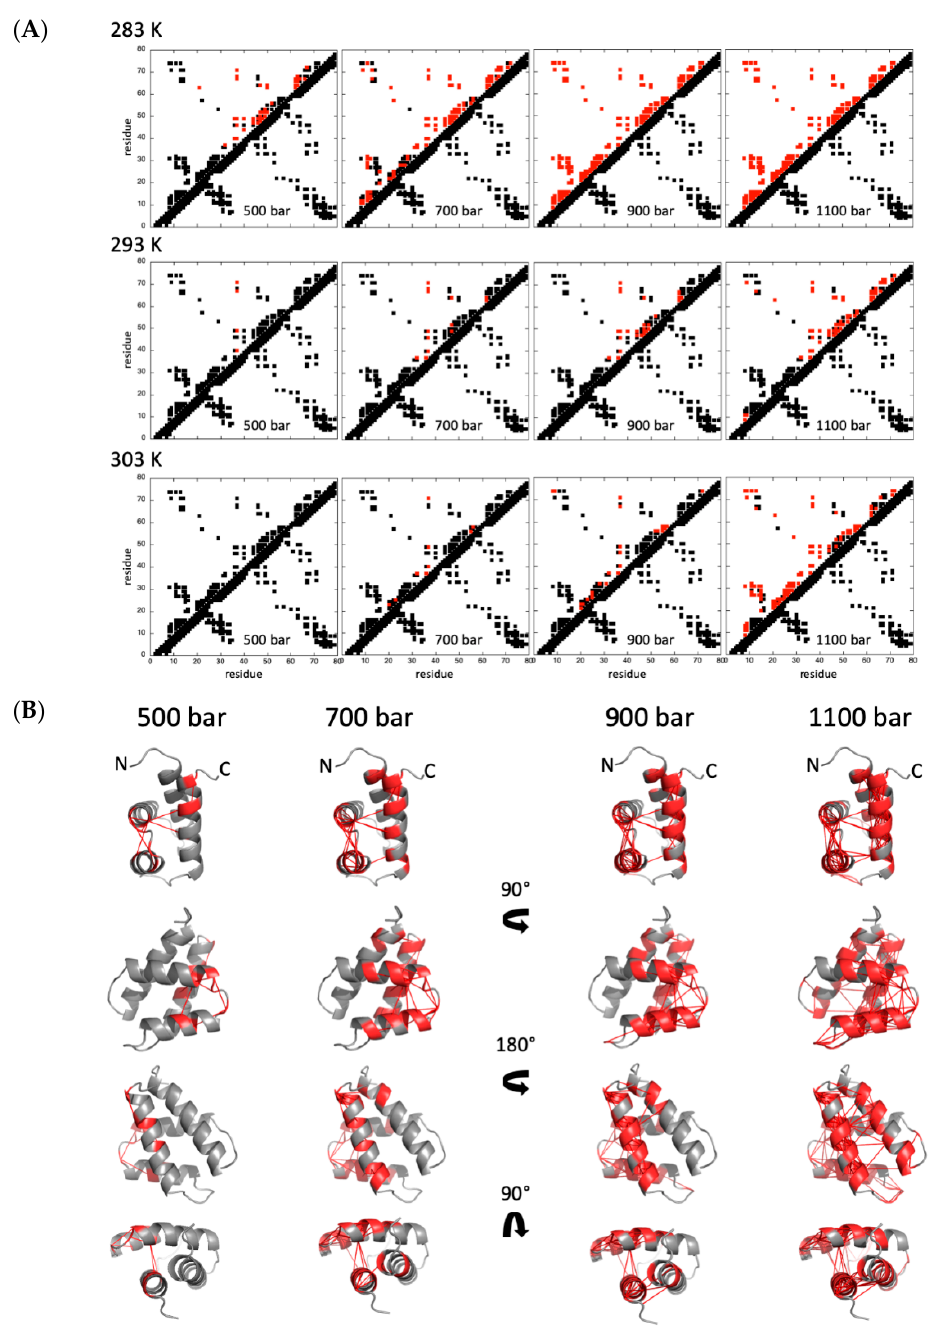
Figure 6. Pressure denaturation of GIPC1-GH2. ( A ) Contact maps built from the best solution structure obtained for GIPC1-GH2 at 500, 700, 900, and 1100 bar, and at 283, 293, and 303 K, as indicated. Contacts below the diagonal have been calculated with CMview (http://www.bioinforma tics.org/cmview/; accessed on 25 March 2020): they correspond to residue where the distance to the corresponding C α is lower than 9 Å. Above the diagonal, only the contacts for which fractional probability can be obtained have been reported. In addition, contacts have been colored in red when contact probabilities P ij lower than 0.5 are observed. ( B ) Visualization of the probabilities of contact on ribbon representations of GIPC1-GH2 at 20 ◦ C and at 500, 700, 900, and 1100 bar, as indicated. The red lines represent contacts that are significantly weakened (P ij ≤ 0.5) at the indicated pressure. Residues involved in these contacts are also colored in red. The arrows in the middle of the panel indicate the rotation between the different